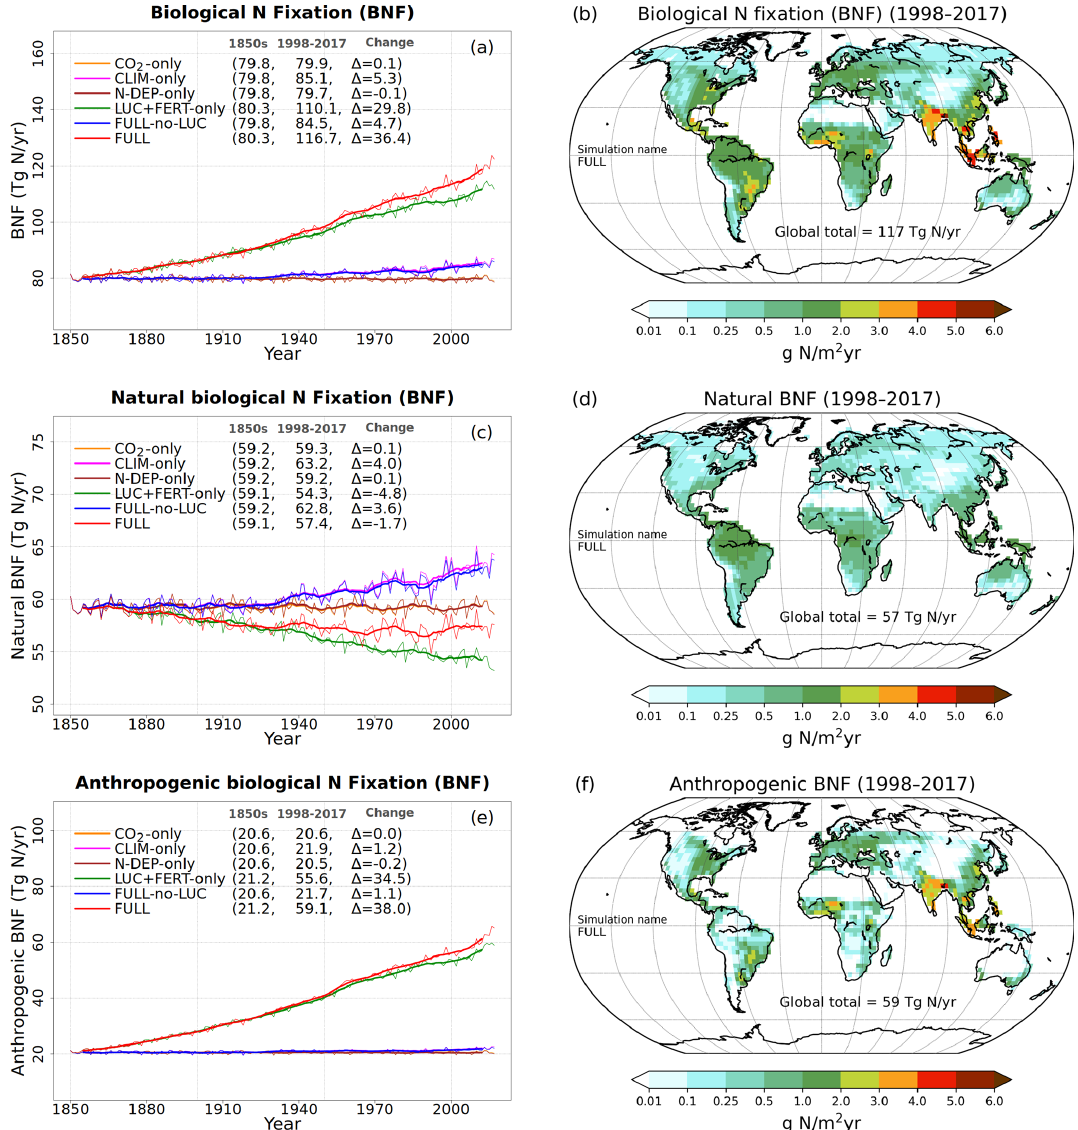
Figure 3. Time series and geographical distribution of annual values of biological N fixation (BNF) (a, b) and its natural (c, d) and anthro- pogenic (e, f) components. The values in the parentheses for legend entries show the average for the 1850s, the average for the 1998–2017 period, and the change between them. The thin lines in the time series plots show the annual values, and the thick lines show their 10-year moving average. The geographical plots show the average values over the last 20 years of the FULL simulation corresponding to the 1998– 2017 period. Note that in the time series plots, lines from some simulations are hidden behind lines from other simulations, and this can be inferred from the legend entries which show averages for the 1850s and the 1998–2017